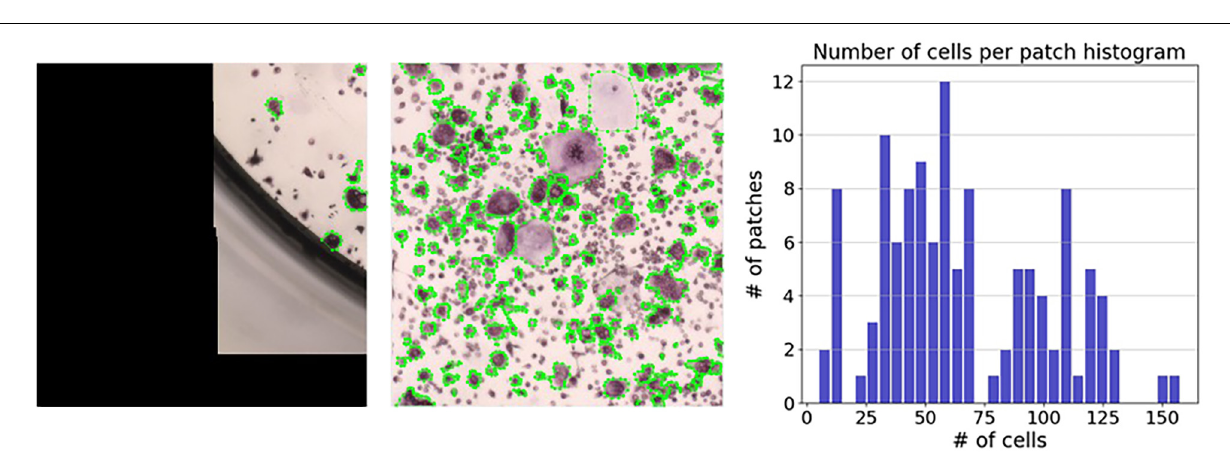
FIGURE 7 | Distribution of the number of cells per region. The number of cells per region ranged from 5 annotated cells (left) to 158 annotated cells (middle). The right panel shows a histogram representing the number of cells per